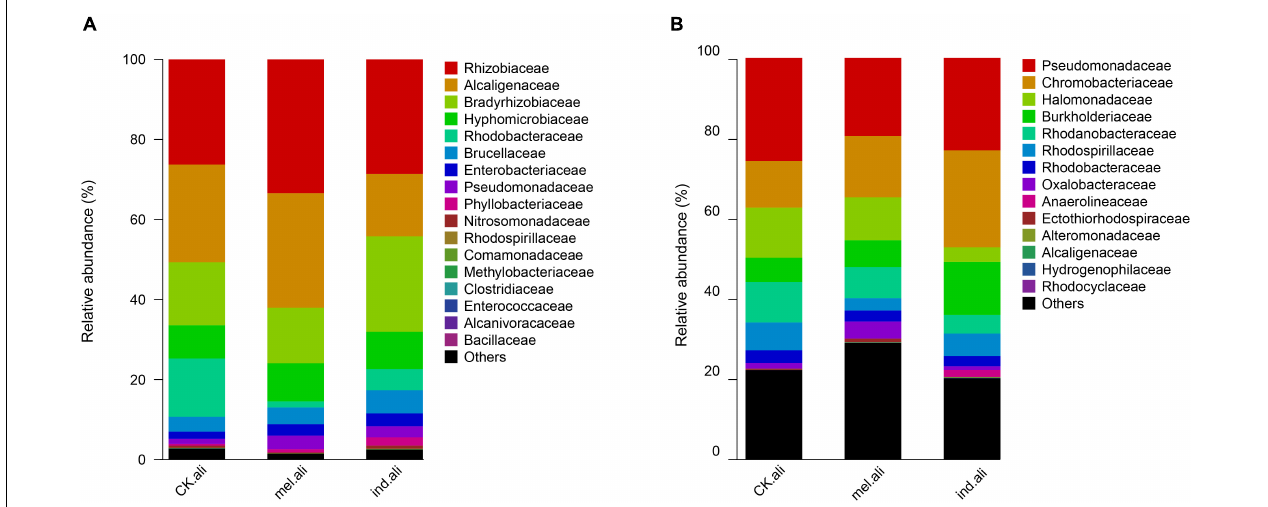
FIGURE 3 | Family level taxonomic composition of (A) nirK - and (B) nirS -type denitrifier communities in the rhizosphere soil of Quercus aliena . CK.ali, uninoculated Q. aliena ; ind.ali, Q. aliena inoculated with Tuber indicum ; and mel.ali, Q. aliena inoculated with Tuber melanosporum .